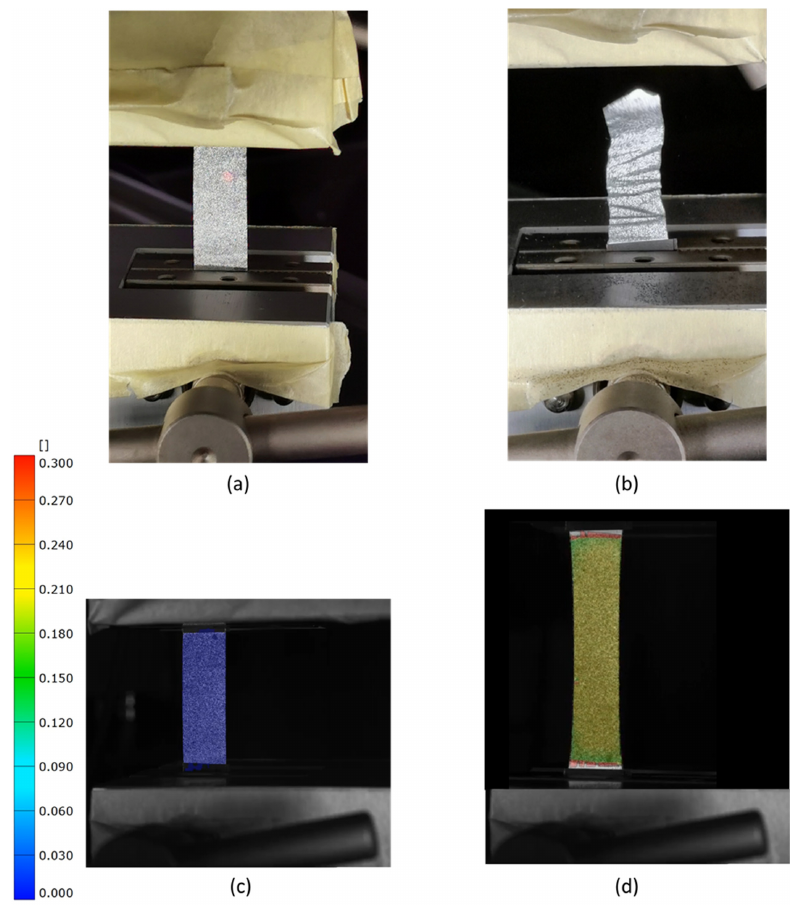
Figure 3. Set-up of prepared specimens in MD before the test ( a ) and at the end of the test, after failure ( b ). Specimen using DIC measurement at the beginning of the test ( c ) and at the end of the test, briefly before failure ( d ), showing the inhomogeneous strain field distribution withing the specimen.